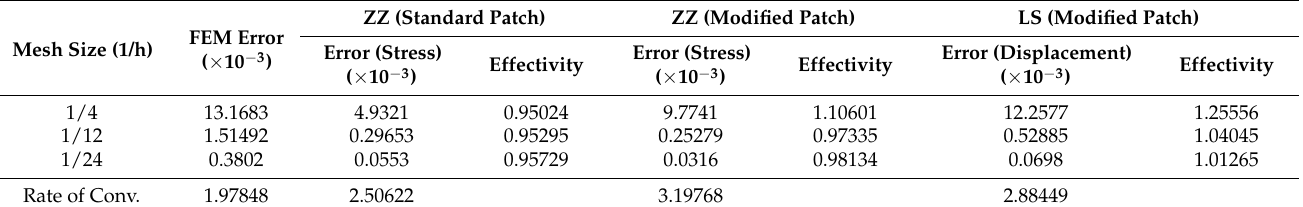
Table 3. Solution error and global effectivity for the plate problem using stress/displacement recovery and patch configura- tion (regular quadratic triangular element).